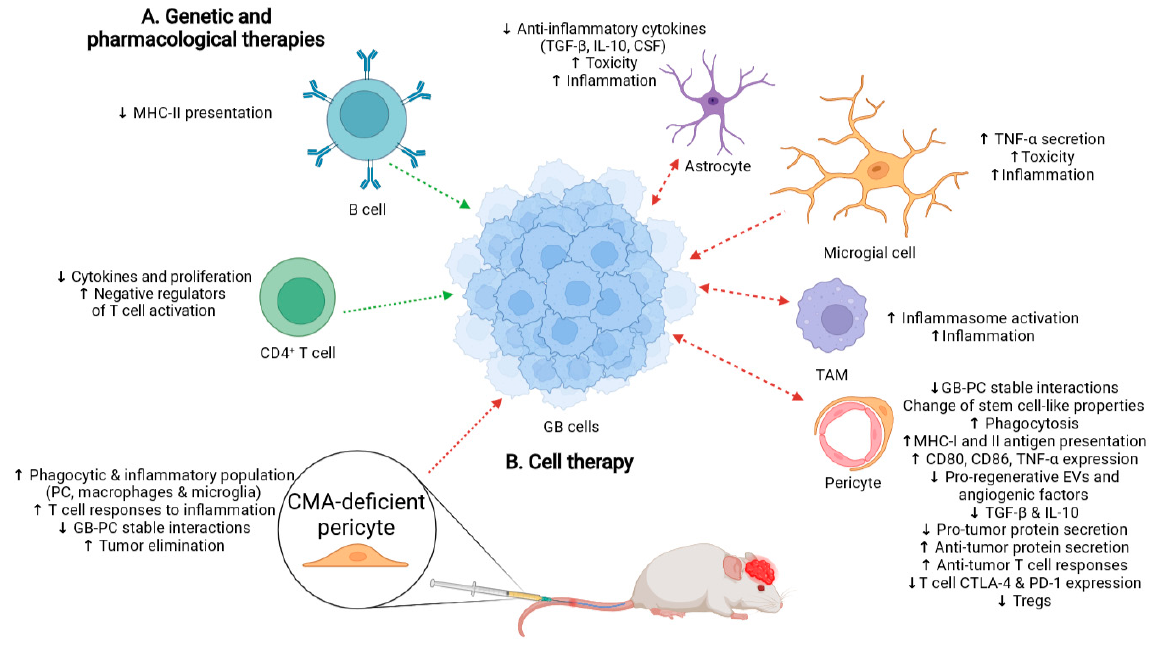
Figure 3. Possible immune responses after CMA inhibition therapies to prevent GB progression. In immune and brain-resident cells, CMA may be altered in different ways in response to GB, and its inhibition might favor tumor progression (green arrows) or promote anti-tumor activity (red ar- rows). Thus, ( A ) future gene and pharmacological therapies against CMA should take into account that cells of the adaptive immune response, such as CD4 + T cells and B cells, require CMA to develop their anti-tumor responses. CD4 + T cells need CMA for proper activation, including cytokine release